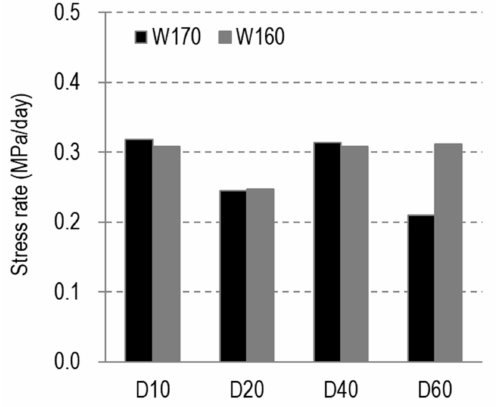
Figure 13. Stress